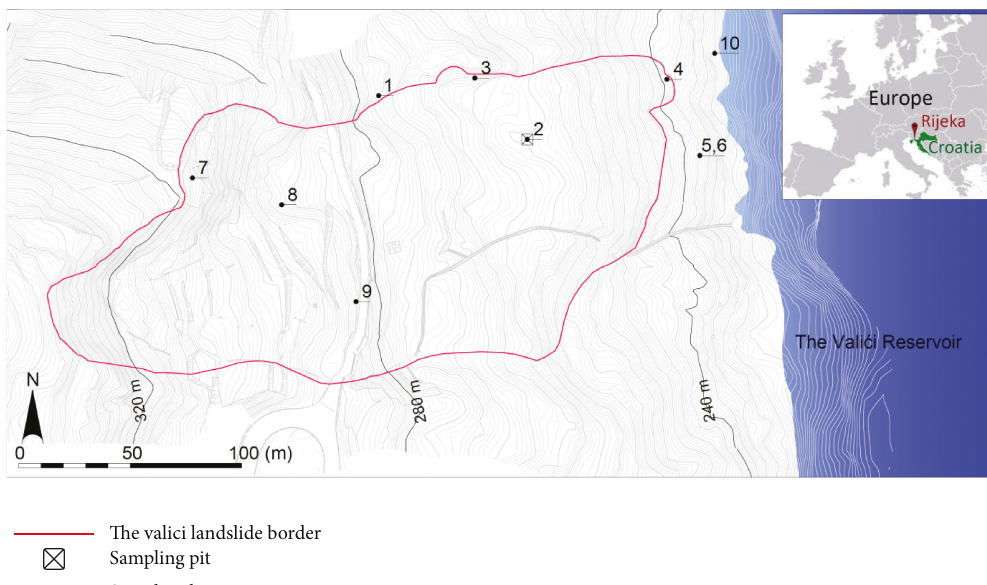
Figure 1: Map of the reactivated landslide on a detailed topographic map with sampling positions